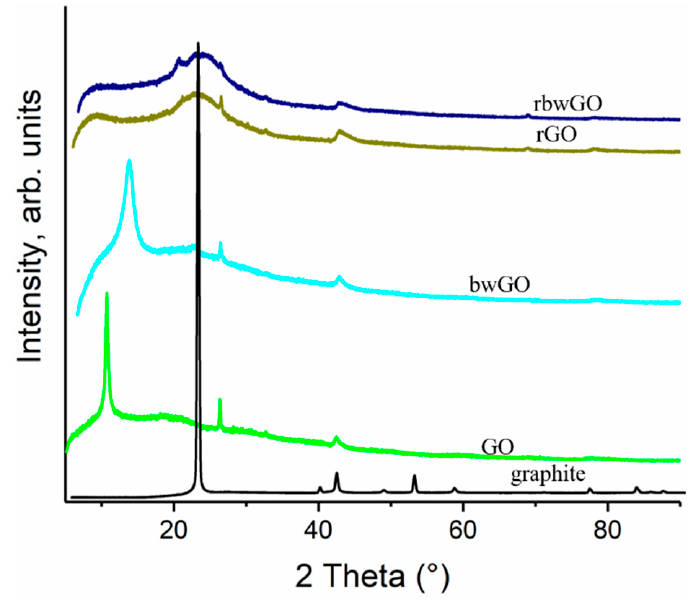
Figure 6. XRD patterns of graphene oxide samples.